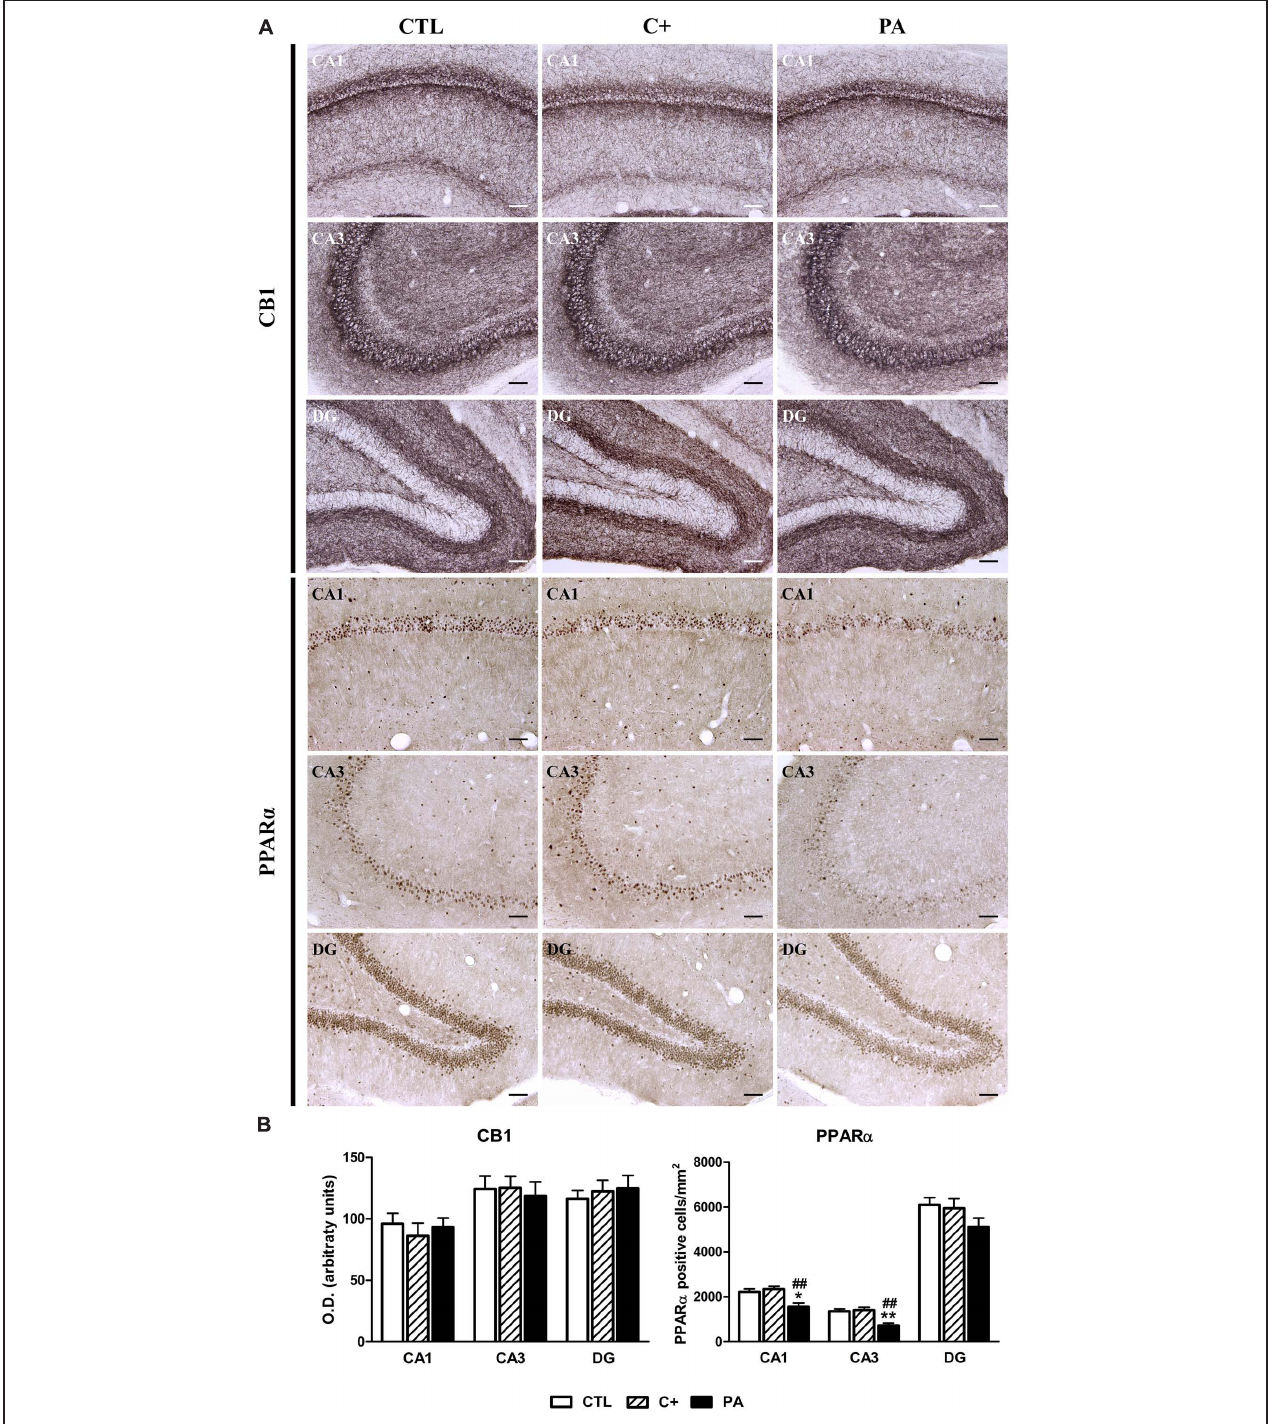
FIGURE 5 | Immunohistochemical expression of CB1 and PPAR α in dorsal hippocampus. (A) Photomicrographs of CB1 (upper panel) and PPAR α (lower panel) immunostaining in CA1, CA3, and DG regions of the dorsal hippocampus in CTL, C + , and PA groups. Scale bars = 15 μ m. (B) Densitometric quantification of CB1 (left panel) and number of PPAR α positive nuclei per mm 2 (right panel) in the Stratum pyramidale of the CA1 and CA3 areas, and in the granular cell layer of the DG region, in the different experimental groups. Bars and error bars show the mean + SEM of 5–7 observations per experimental subject of a total of 5–6 animals per group. ∗ p < 0.05 vs. CTL; ∗∗ p < 0.01 vs. CTL; ## p < 0.01 vs. C + . CTL, control group; C + , cesarean section group; PA, perinatal asphyxia group; CA1, cornu ammonis 1; CA3, cornu ammonis 3; DG, dentate gyrus.